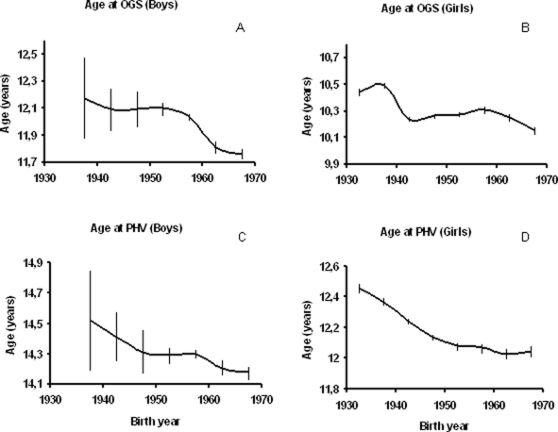
Trends in age at OGS and PHV.Age at onset of pubertal growth spurt (Age at OGS) in boys (A) and girls (B), and age at peak height velocity (Age at PHV) in boys (C) and girls (D) according to year of birth. Curves are smoothed by 5-year intervals (e.g. 1930–1934, 1935–1939, 1940–1944 etc.) and presented with confidence intervals.